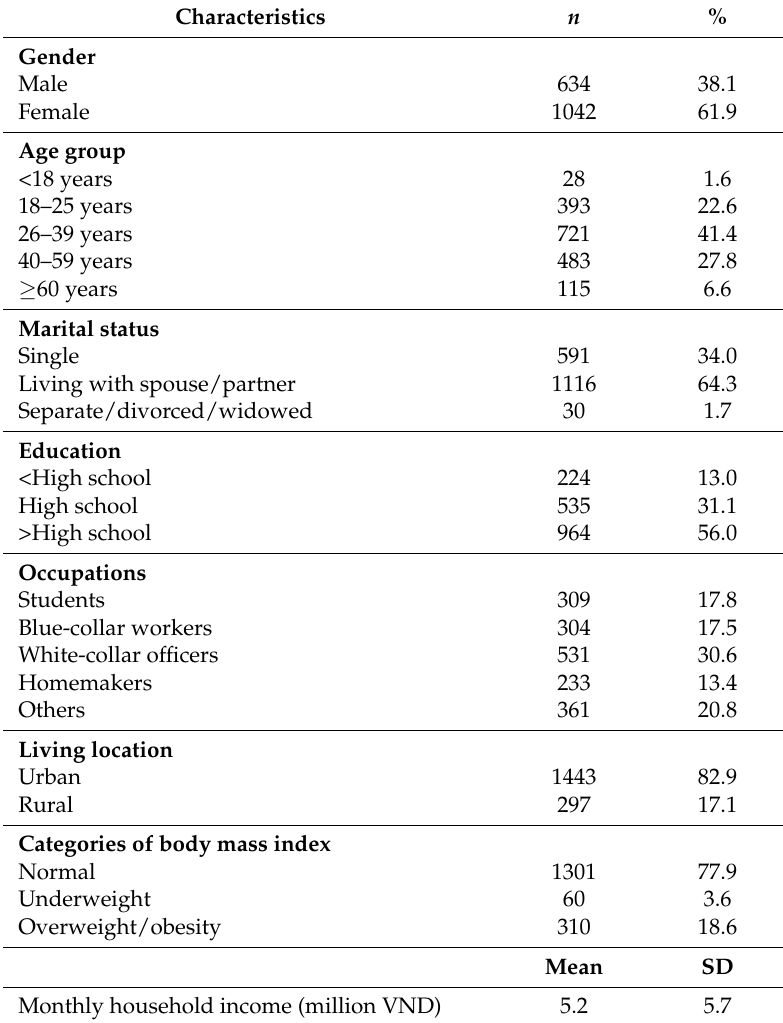
Table 1. Demographic characteristics of customers and food